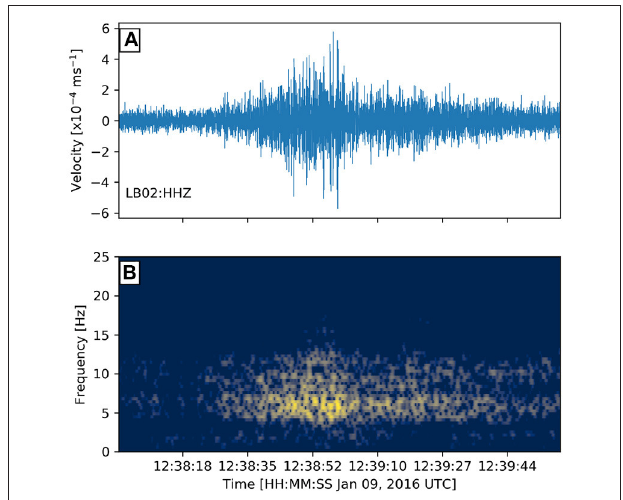
FIGURE 9 | Seismic record (A) and frequency spectrogram (B) of rockfall recorded at station LB02 on 9th January 2016. A high-pass filter at 0.5 Hz has been applied to the seismic record. The source location for this event was down the western flank of Caliente dome. A thermal recording of the event can be seen in Movie S1 . Spectral scale is identical to that in Figure 5